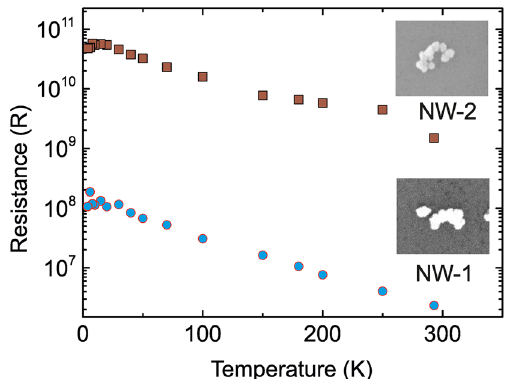
Figure 4. Resistance versus temperature curves for two Au-metallized C-shape nanowires, named NW-1 and NW-2, templated by DNA origami in the 4.2 K to RT temperature range. Scanning electron microscopy images of the two nanowires can be seen as inset